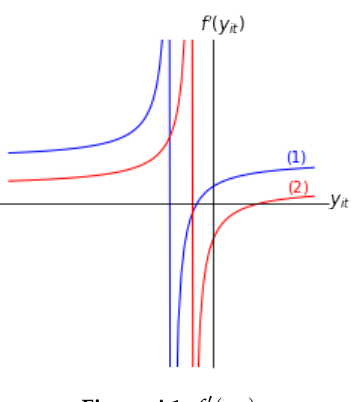
Figure A1. f (cid:48) ( y it )